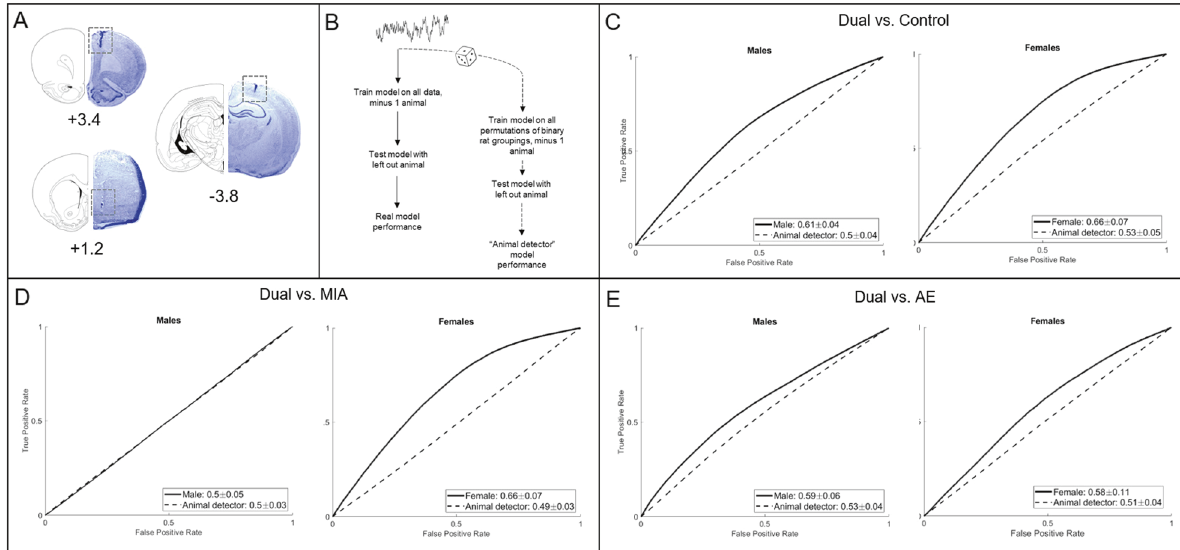
Fig. 5 Cortical-striatal-hippocampal LFPs predict MIA and/or AE exposure. A Histologic representation of lesions caused by electrode cannula in the mPFC ( + 3.4 mm from bregma), NAcSh ( + 1.2 mm from bregma), and CA1 ( − 3.8 mm from bregma). Electrode wires extended 1 mm from the end of the cannula for the NAcSh, CA1, and PL, and 2 mm for the IL. B Schematic representation of the baseline model building. C LFPs predicted Dual rats from control rats better than the “ animal detector ” in both males and females (5 – 10/group/sex from 7 dams). D LFPs predicted Dual rats from MIA rats better than the “ animal detector ” in females, but not in males ( n = 5 – 13/group from 6 dams). E LFPs predicted Dual rats from AE rats better than the “ animal detector ” in both males and females ( n = 5 – 10/group/sex from four